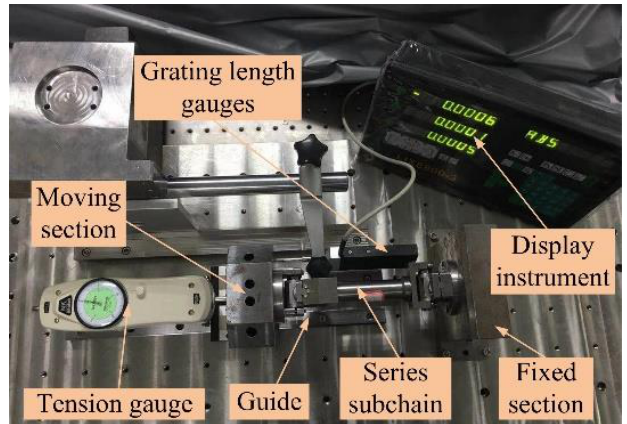
Figure 13. Stiffness testing setup for the RR-R-RR serial subchain.